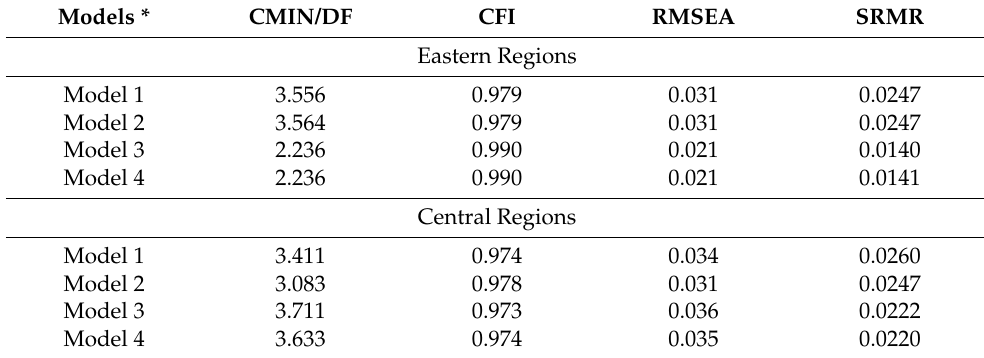
Table A3. Specific model fits of each model. Models